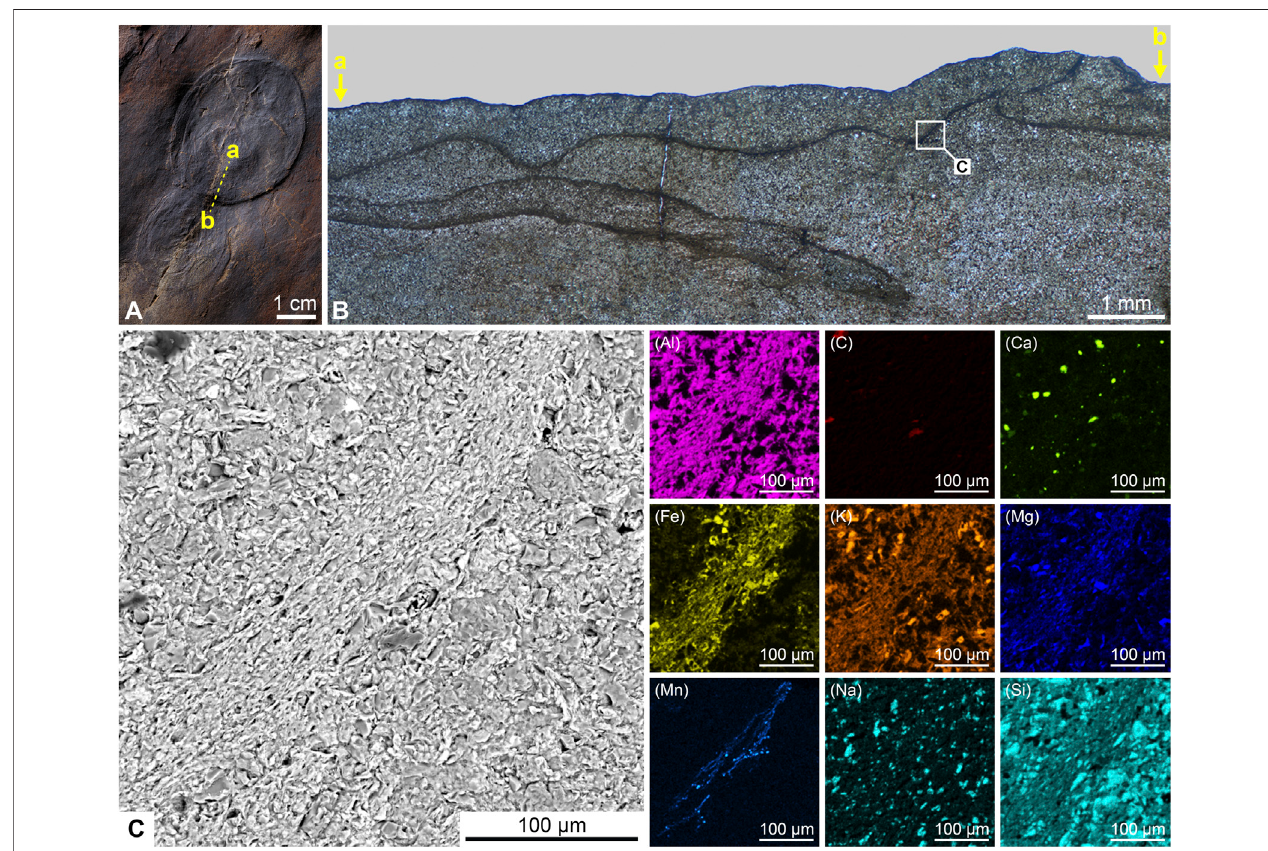
FIGURE 2 | Three-dimensional preservation of Beltanelliformis konovalovi sp. nov. on the upper bedding surface in fi ne-grained sandstone: (A) CU2019/004, specimens adjoined to each other (dashed line marks a thin section surface); (B) photograph of thin section under optical microscope (white frame marks area studied in SEM); (C) back-scattered electron image of thin section and elemental mapping of the ultra-thin rim around specimen.